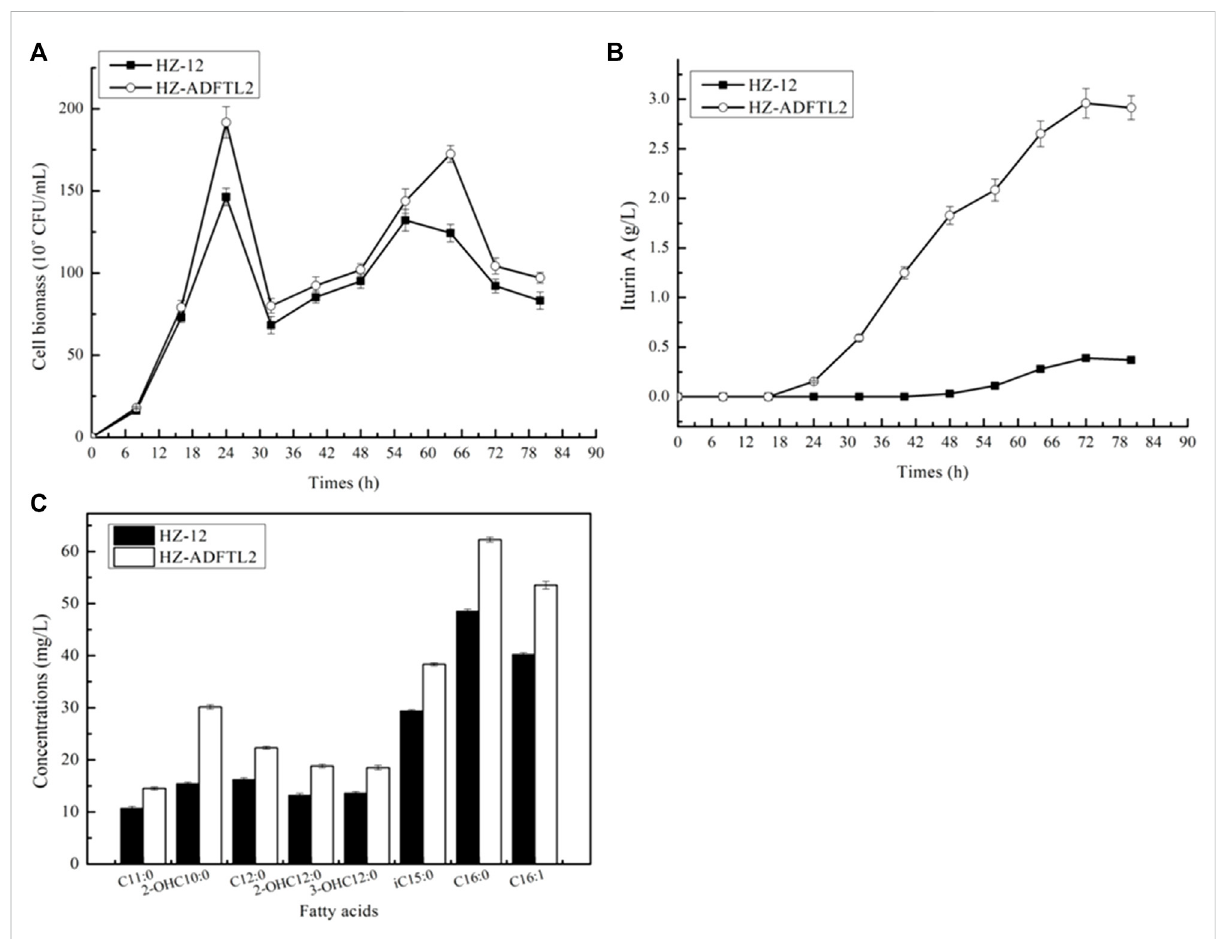
FIGURE 6 Fermentation analysis of B. amyloliquefaciens HZ-12 and HZ-ADFTL2 strains. (A) Cell biomass, (B) iturin A yields, and (C) fatty acid